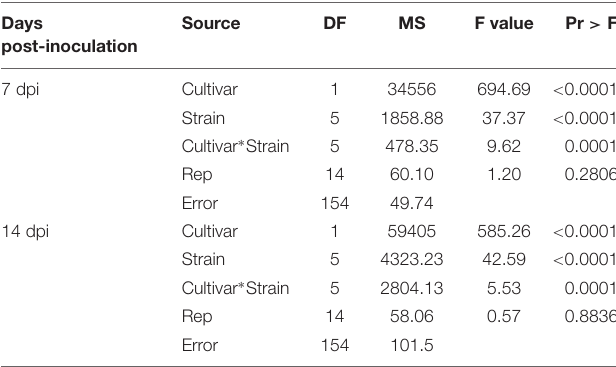
TABLE 1 | Analysis of variance (ANOVA) table for cultivar, strain and their interaction for Fusarium head blight disease severity at 7 and 14 days post-inoculation.